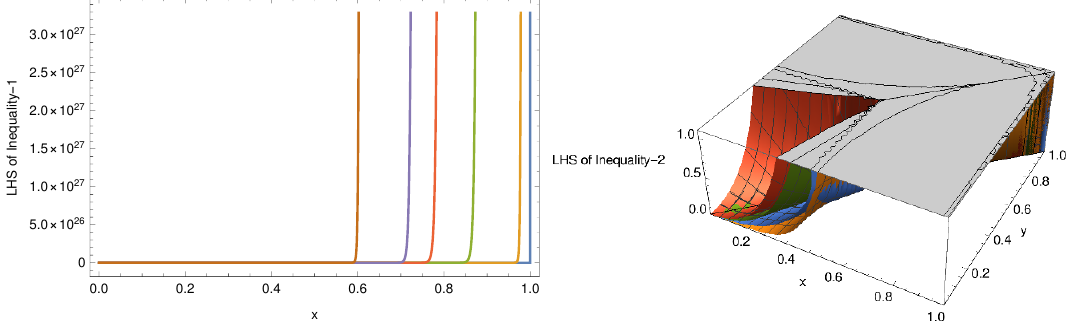
Figure 4 . Verifying the second R(cid:19)enyi inequalities | (7.13) on left and (7.14) on right | for two intervals, for extremal CFTs with di(cid:11)erent values of central charges. The (cid:12)rst plot is for k = 1 ; 5 ; 10 ; 15 ; 20 ; 45, (the curves from left to right are for decreasing k ) while the second one is for k = 1 ; 15 ; 30 ;